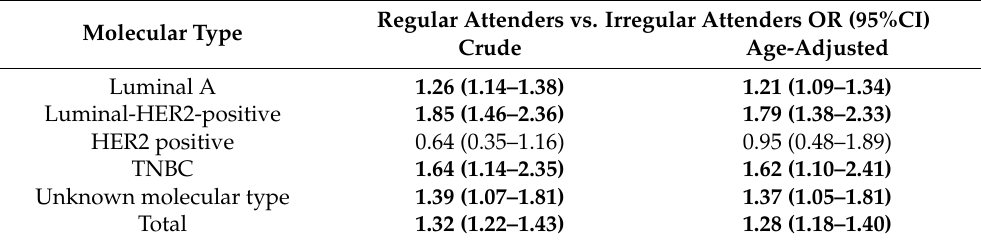
Table 4. The effect of screening regularity on the model of breast cancer detection (screen-detected vs. interval) ( n =